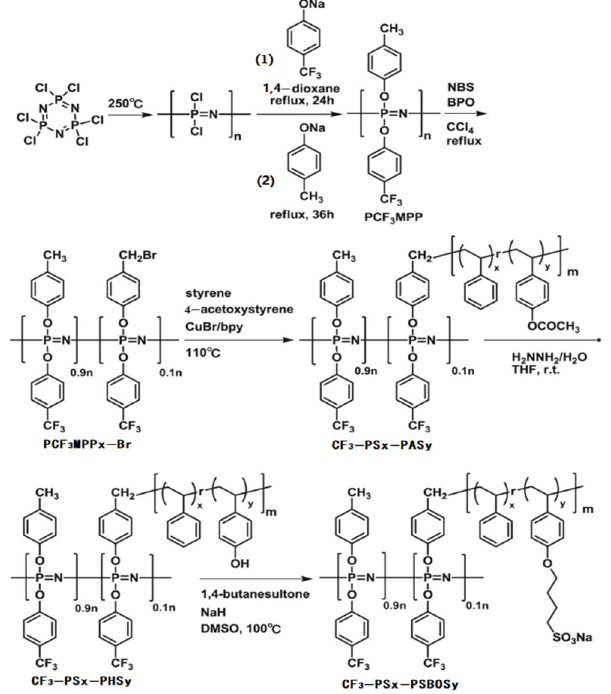
Figure 4. The schematic diagram of membrane preparation progress. Taken with permission from [102]. from [102].